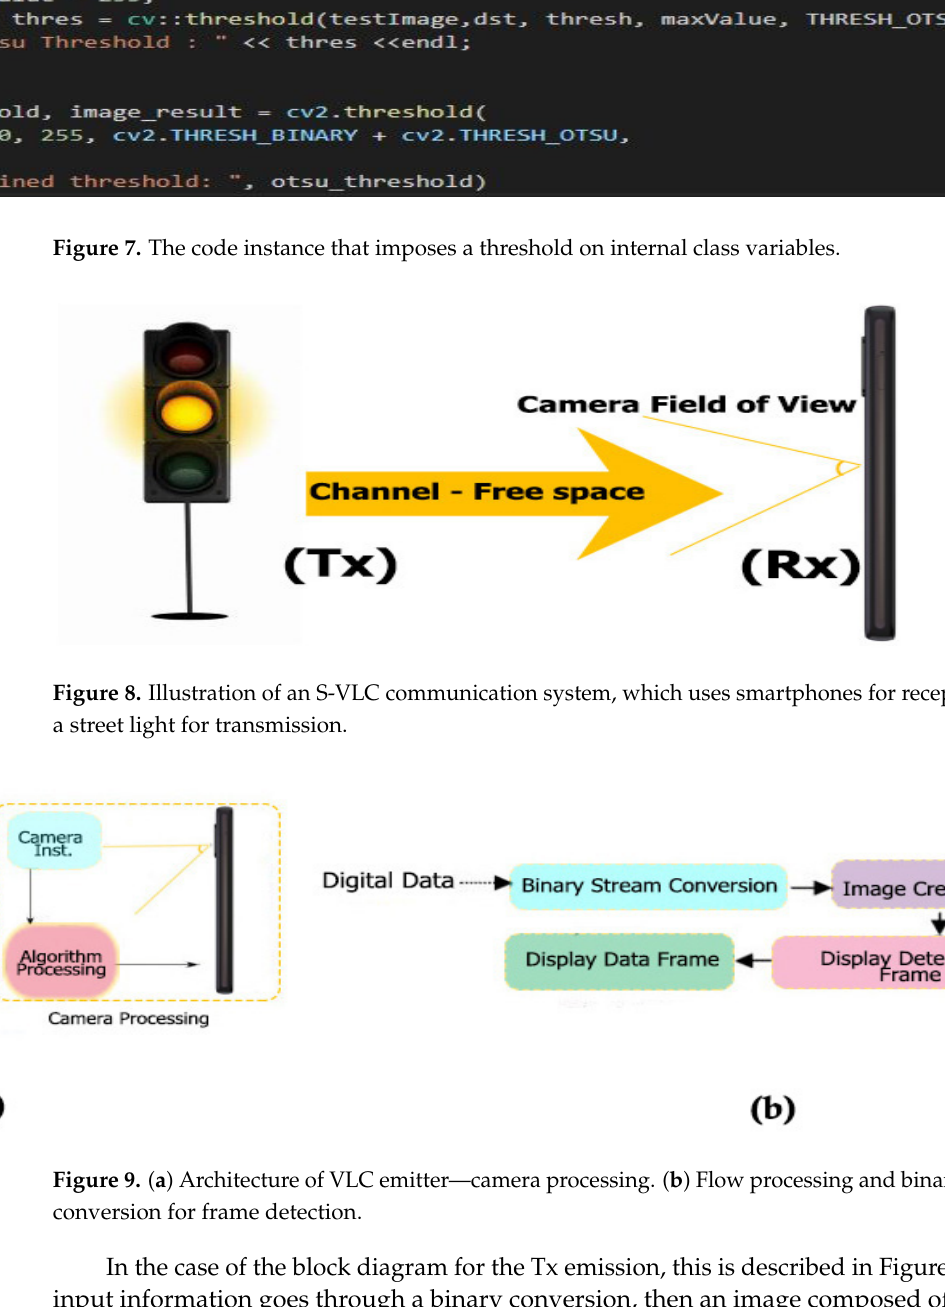
Figure 7. The code instance that imposes a threshold on internal class variables.